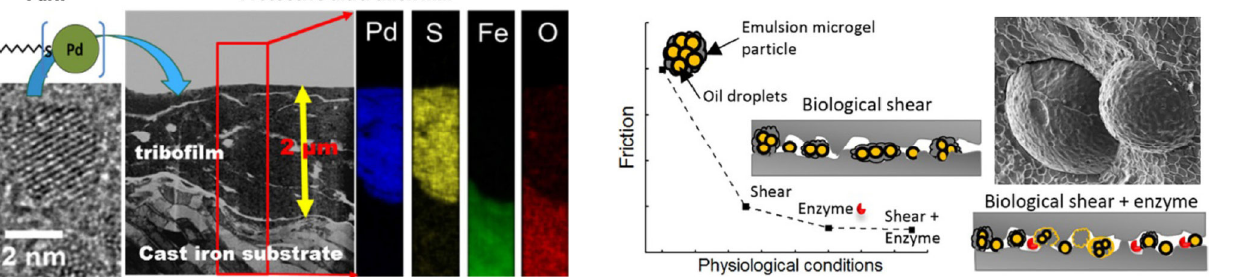
Fig. 14 The image and composition of the ultrathick tribofilm. Reproduced with permission from Ref. [162]. © American Chemical Society, 2018.